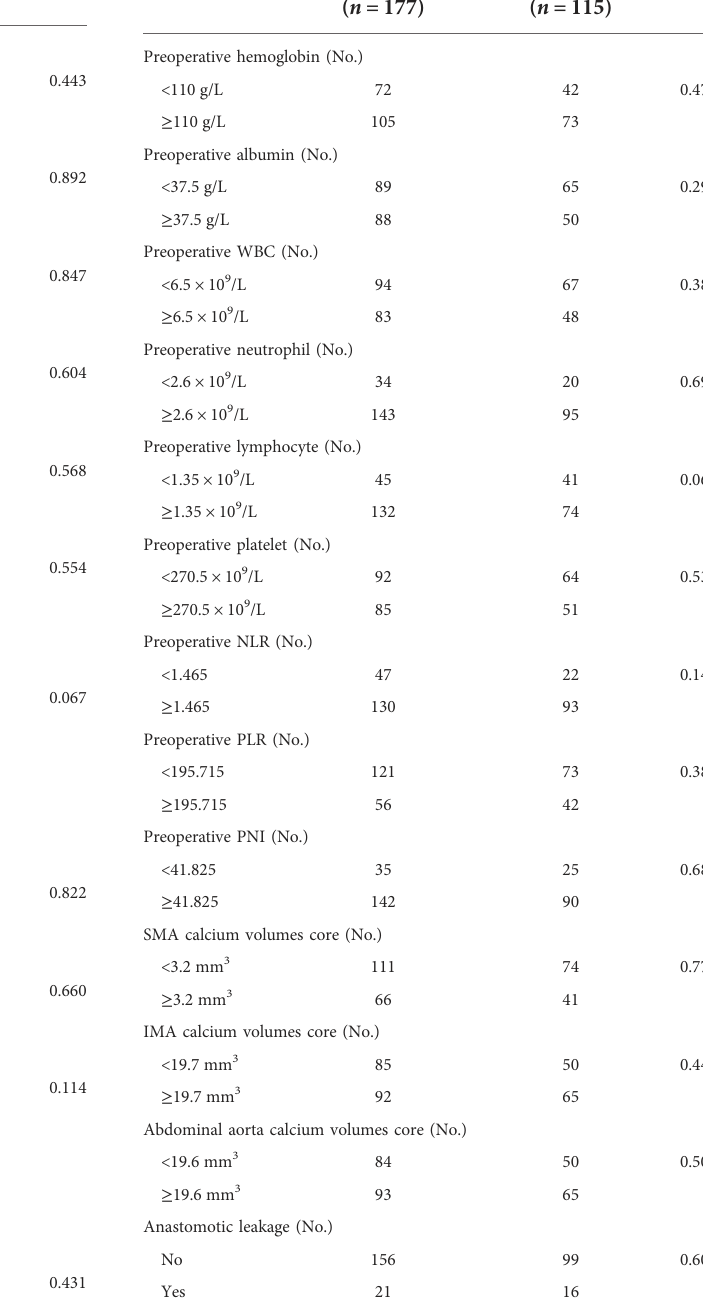
TABLE 2 Comparison of patients in the training and validation cohorts.